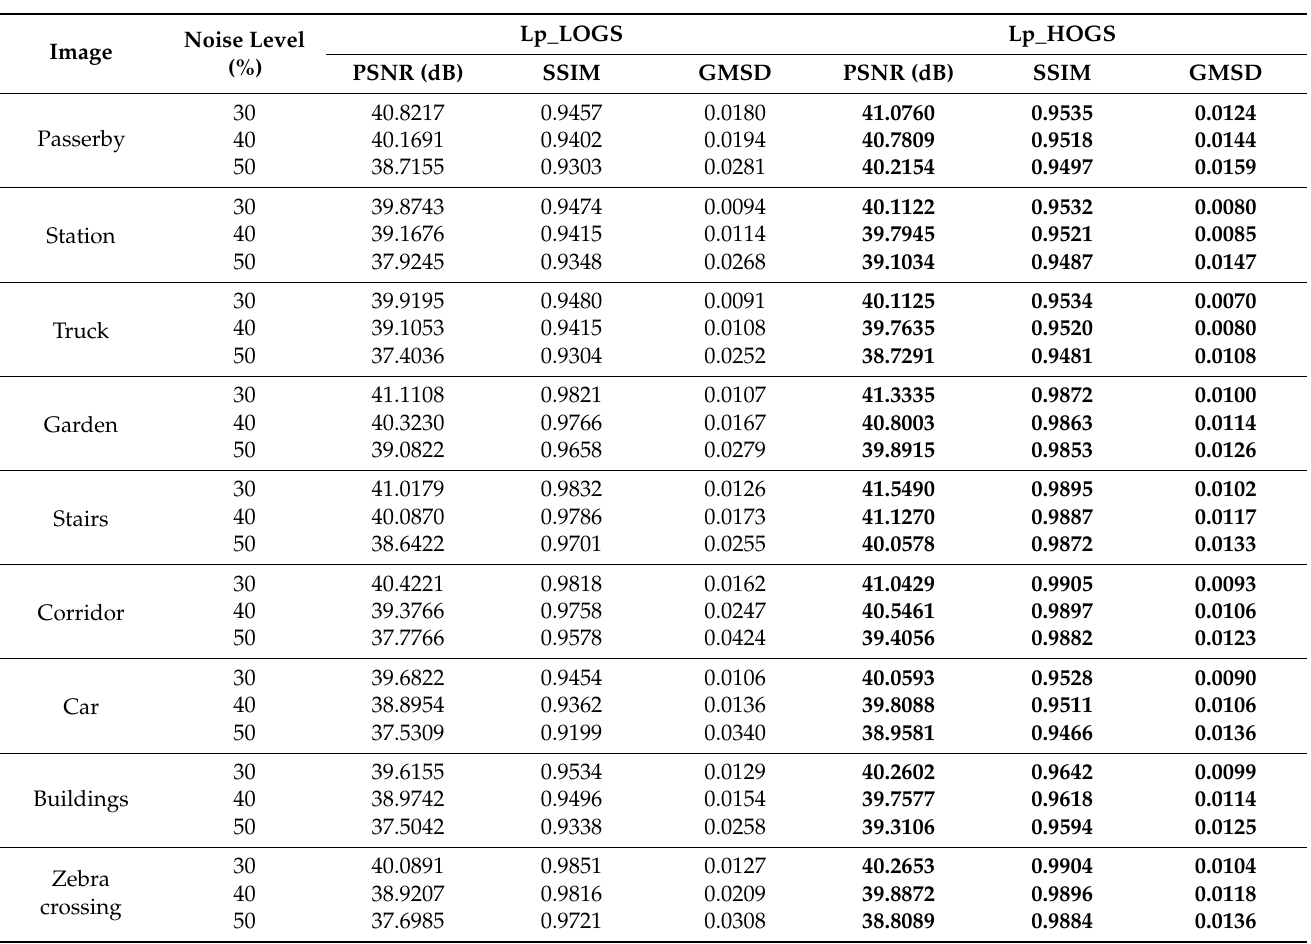
Table 2. The Lp_HOGS and Lp_LOGS deblurring effects on images with a 7 × 7 box blur. The optimal indicators for each condition are denoted in